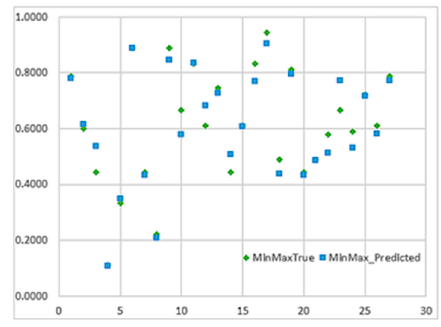
Figure 10. ANN input vs. predicted values.